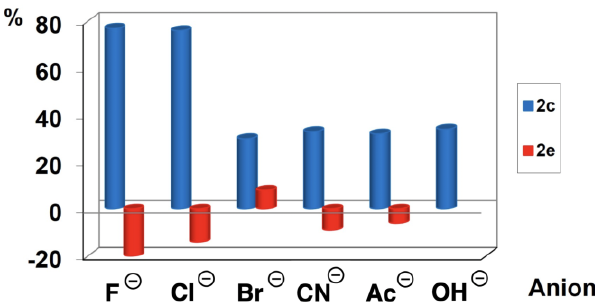
Figure 8. Comparison of the fluorescence response of the sensors 2c and 2e for the different anions studied.